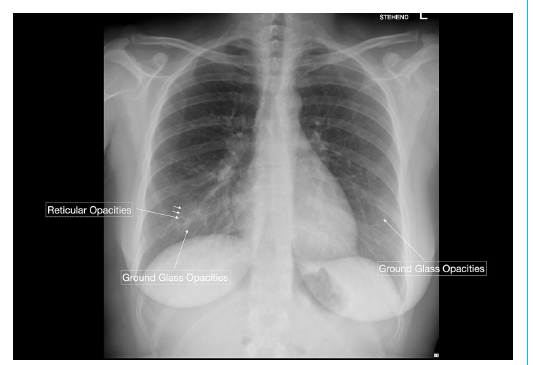
Figure 4: A 31-year-old female patient working as a waitress pre- sented with episodes of high fever and progressive shortness of breath. Chest x-ray, performed at the same time as nasopharyn- geal RT-PCR testing, showed very subtle evidence of faint ground glass opacities and with a superimposed reticular pattern, which raised the high suspicion of an early stage COVID-19 infection. No consolidation or pleural effusions were evident. RT-PCR test re- sults available after 48 hours confirmed COVID-19.